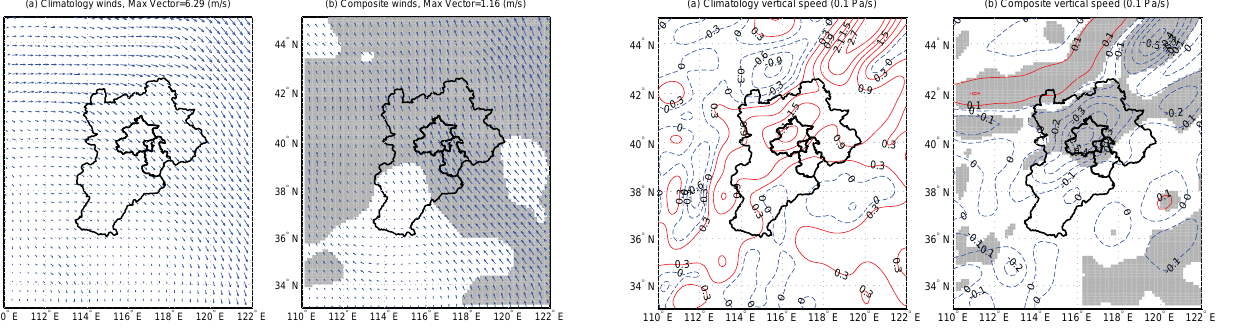
Figure 7. The climatological mean (a) and the composite (b) wind fields averaged from 1000 to 900hPa (areas significant at the 0.05 level are shaded).